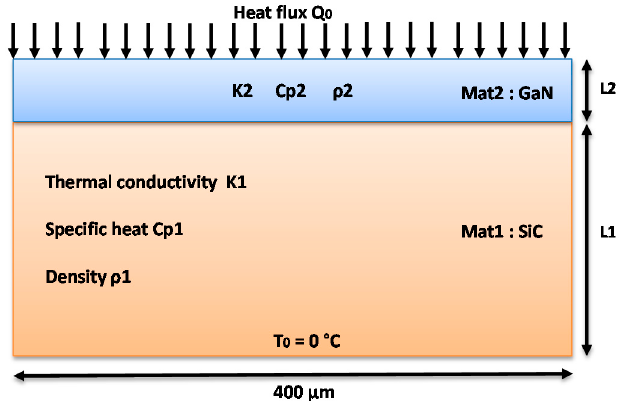
Figure 6. 1-D, two-layer structure.